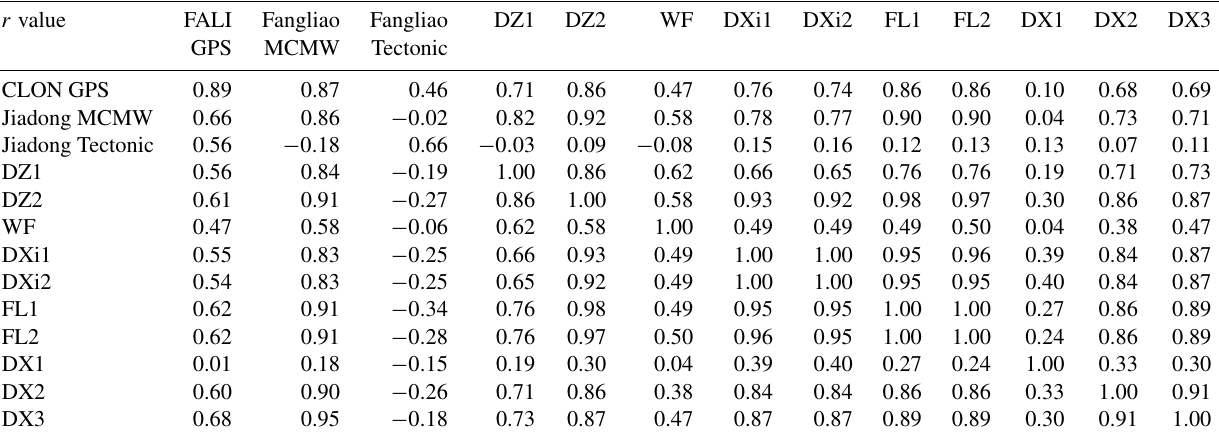
Table 1. Correlation coefficient matrix between subsidence and groundwater level. r value FALI Fangliao Fangliao GPS MCMW Tectonic CLON GPS Jiadong MCMW Jiadong Tectonic